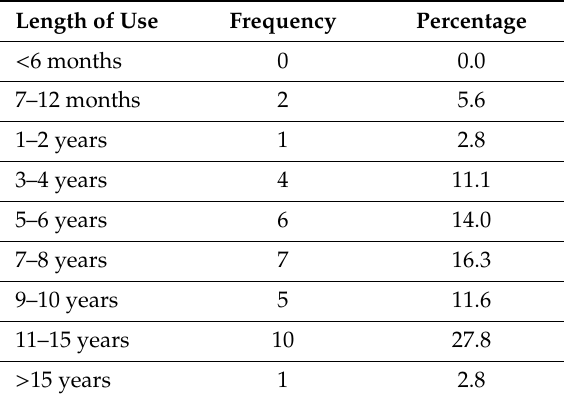
Table 19. Length of BSC use (N =